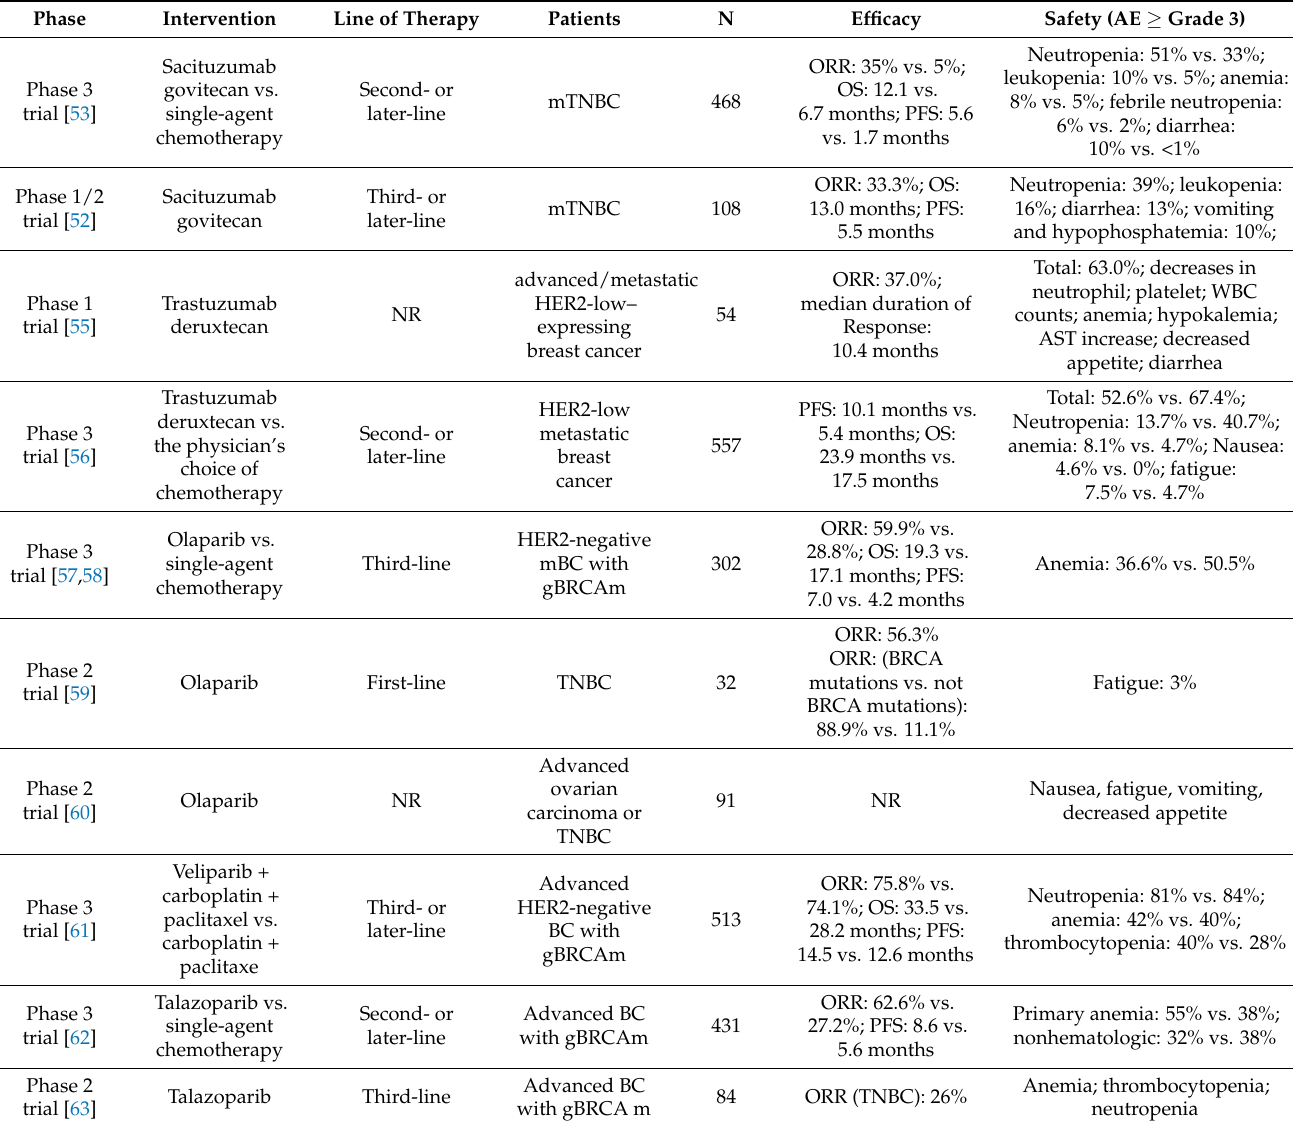
Table 2. Clinical trials of novel targeted therapeutic agents approved for